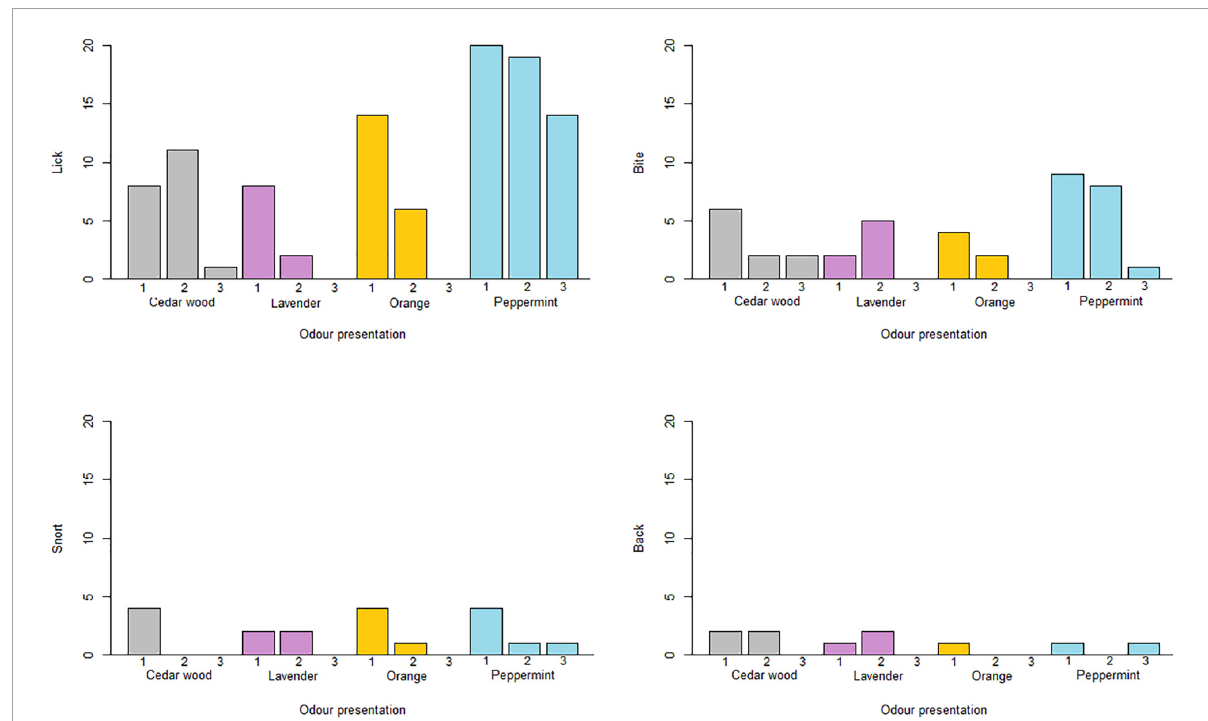
FIGURE4 The total number of horses expressing licking, biting, snorting and backing separately when presented with each of the odors 1st, 2nd, and 3rd, time. Orange represent orange, light blue represents peppermint, purple represents lavender and light gray represents cedar wood.